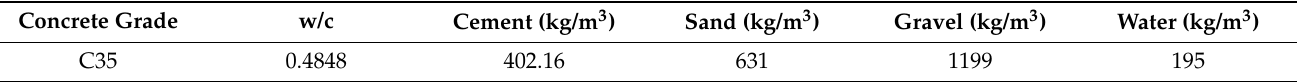
Table 2. Mixture proportion of concrete in the present study.